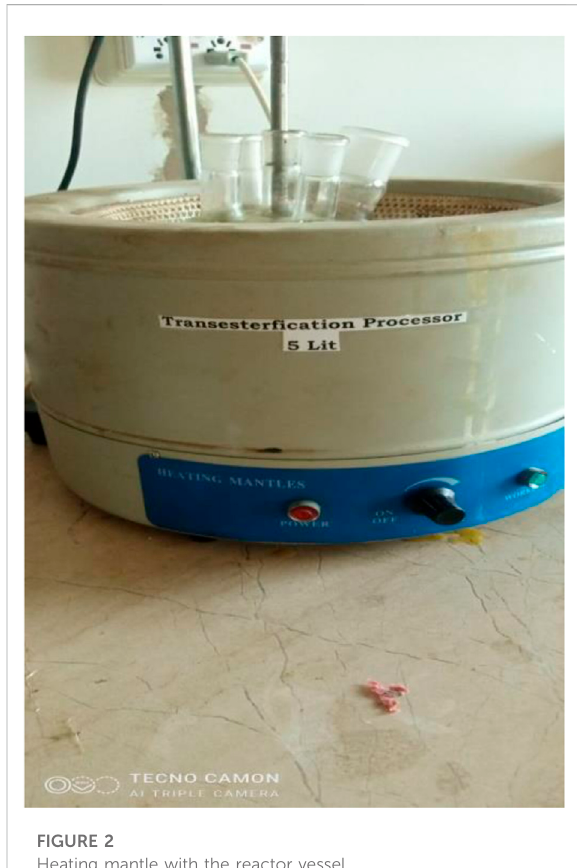
FIGURE 2 Heating mantle with the reactor vessel.